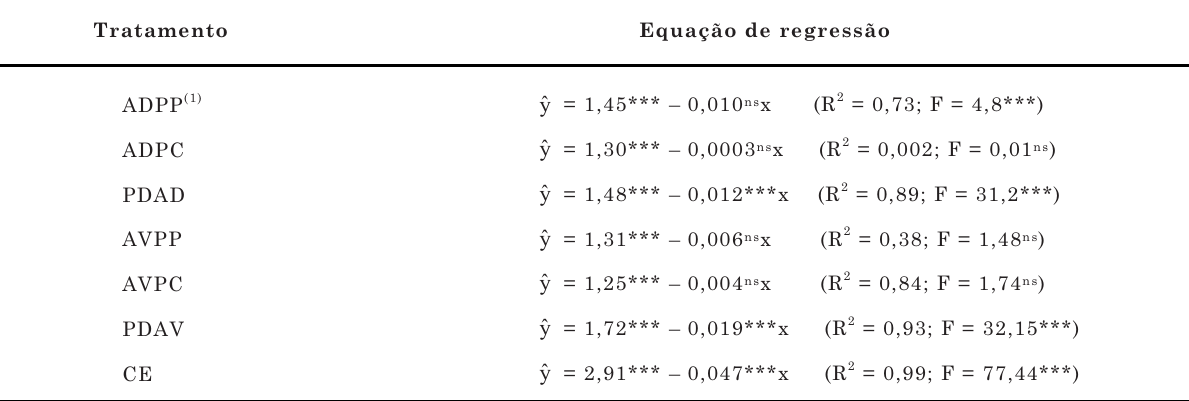
guidos da mesma letra na mesma coluna não apresentam dife- renças significativas entre si pelo teste t a 5 %. ***: Significa- tivo a 1 % pelo teste